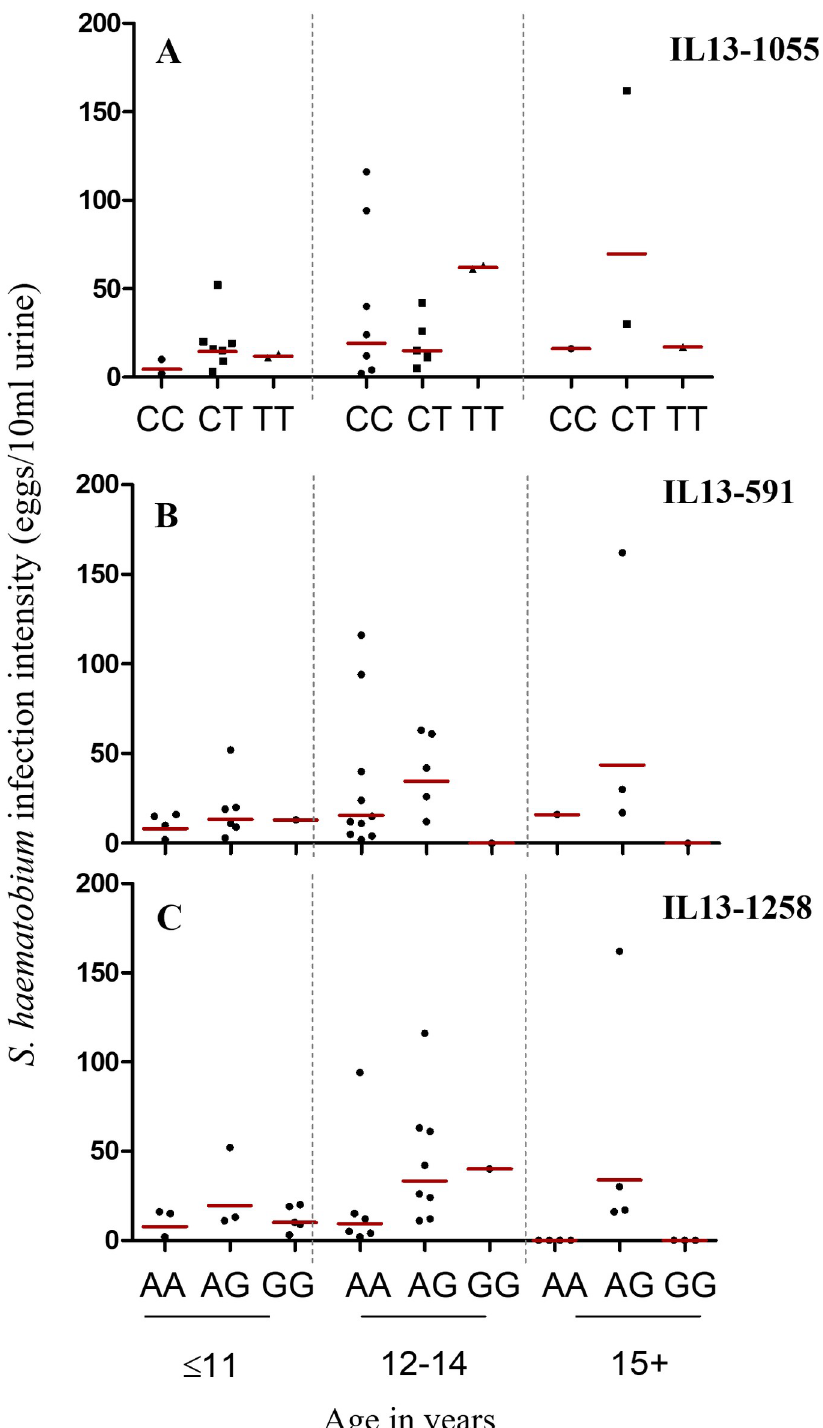
Fig 4. Geometric mean (GM) S . haematobium infection intensity distribution by Age for IL13-1055C/T, IL13- 591A/G, and IL13-1258A/G polymorphisms. Red horizontal lines denote the GM intensity for the respective groups.